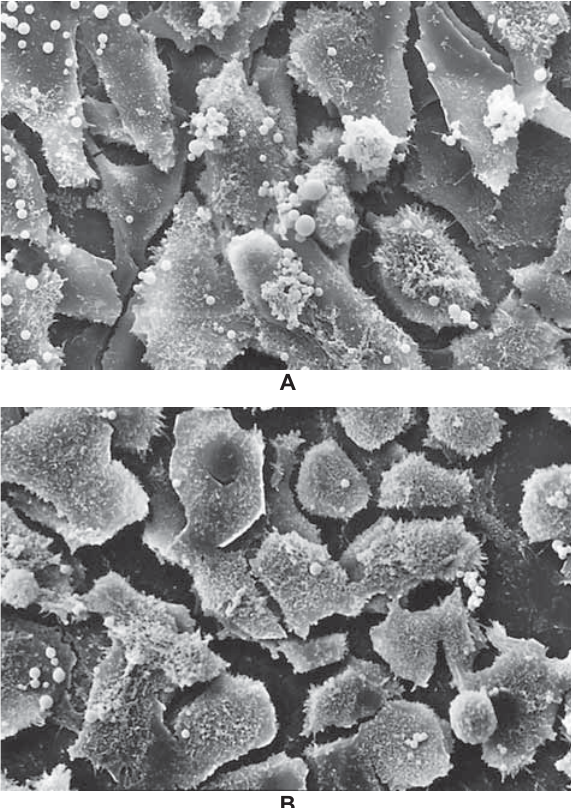
Figure 3- Panel of SEM micrographs representative of cell morphology. A - Group 2 (20 s) - Presence of few small-sized and round-shaped cells with few cytoplasmic processes; B - Group 1 (dark-curing) - Presence of a small number of cells adhered to the glass substrate and structures suggestive of rests of degraded cell